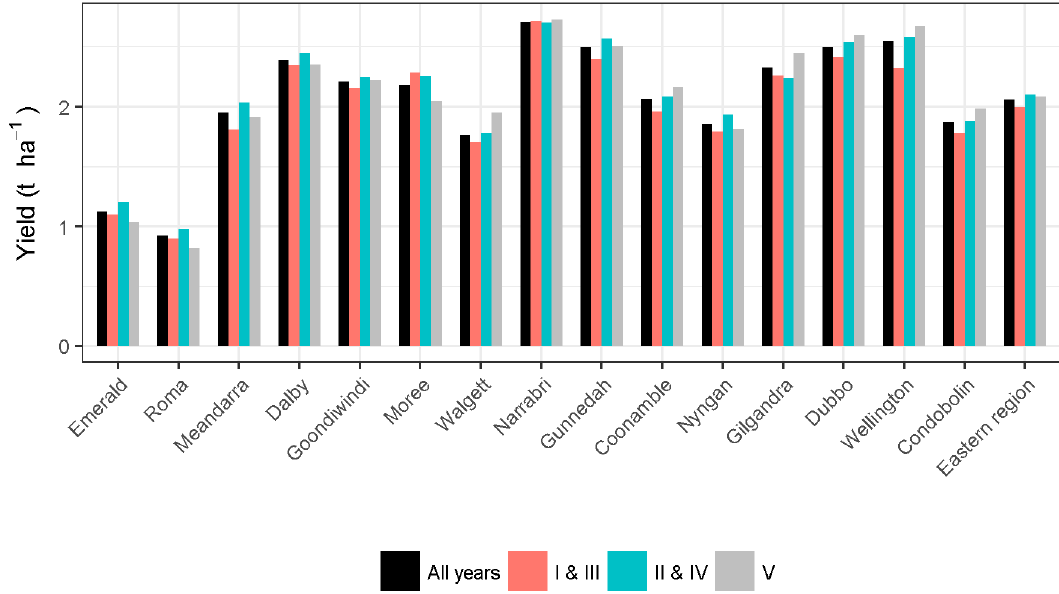
Figure 3. Simulated average yield in the baseline scenario for all years (1900–2016) and for years from each of the three SOI classes at 15 sites across the Eastern wheatbelt and for the whole Eastern wheatbelt region. Baseline simulations corresponded to a standard farmer practice (a medium-season cultivar Janz was sown at semi-optimum sowing date (21 May) with current fertilisation practice). The three SOI classes correspond to SOI consistently negative and rapidly failing (SOI phases I & III), SOI consistently positive and rapidly rising (SOI phases II & IV), and SOI consistently near zero (SOI phase V). SOI phases were determined in March–April, prior to sowing.